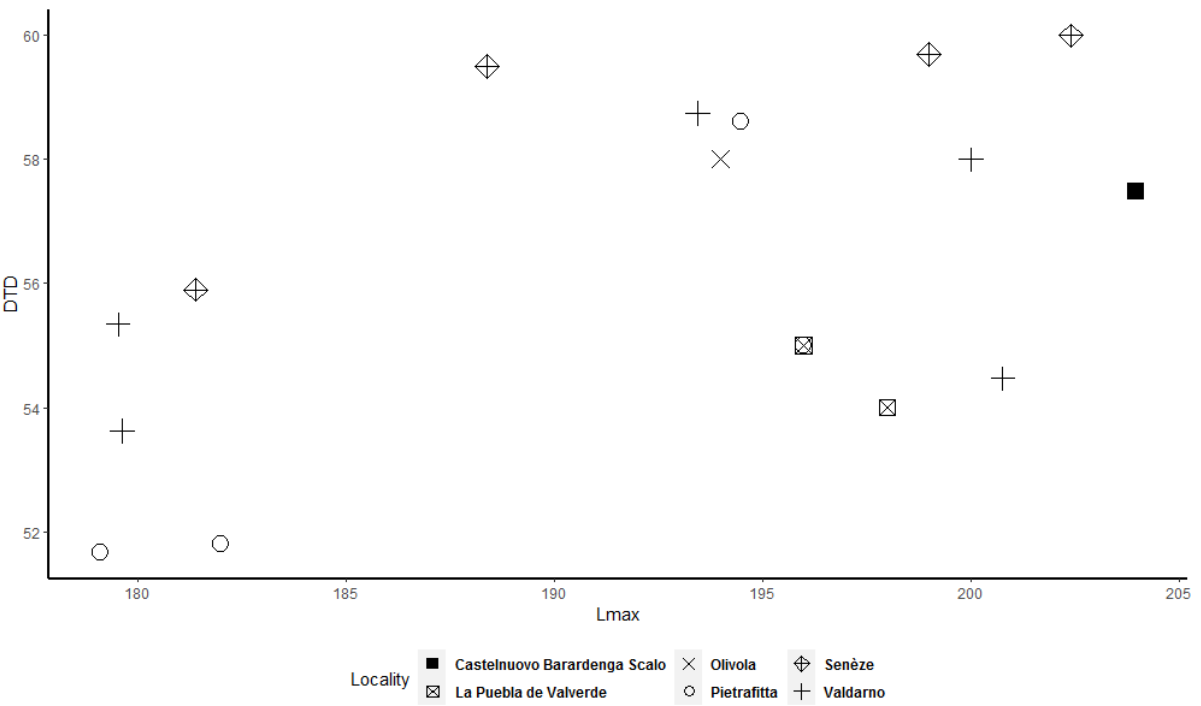
Figure 11. Scatterplot between the maximum length (Lmax) and the distal transverse diameter (DTD) of the MCIII.